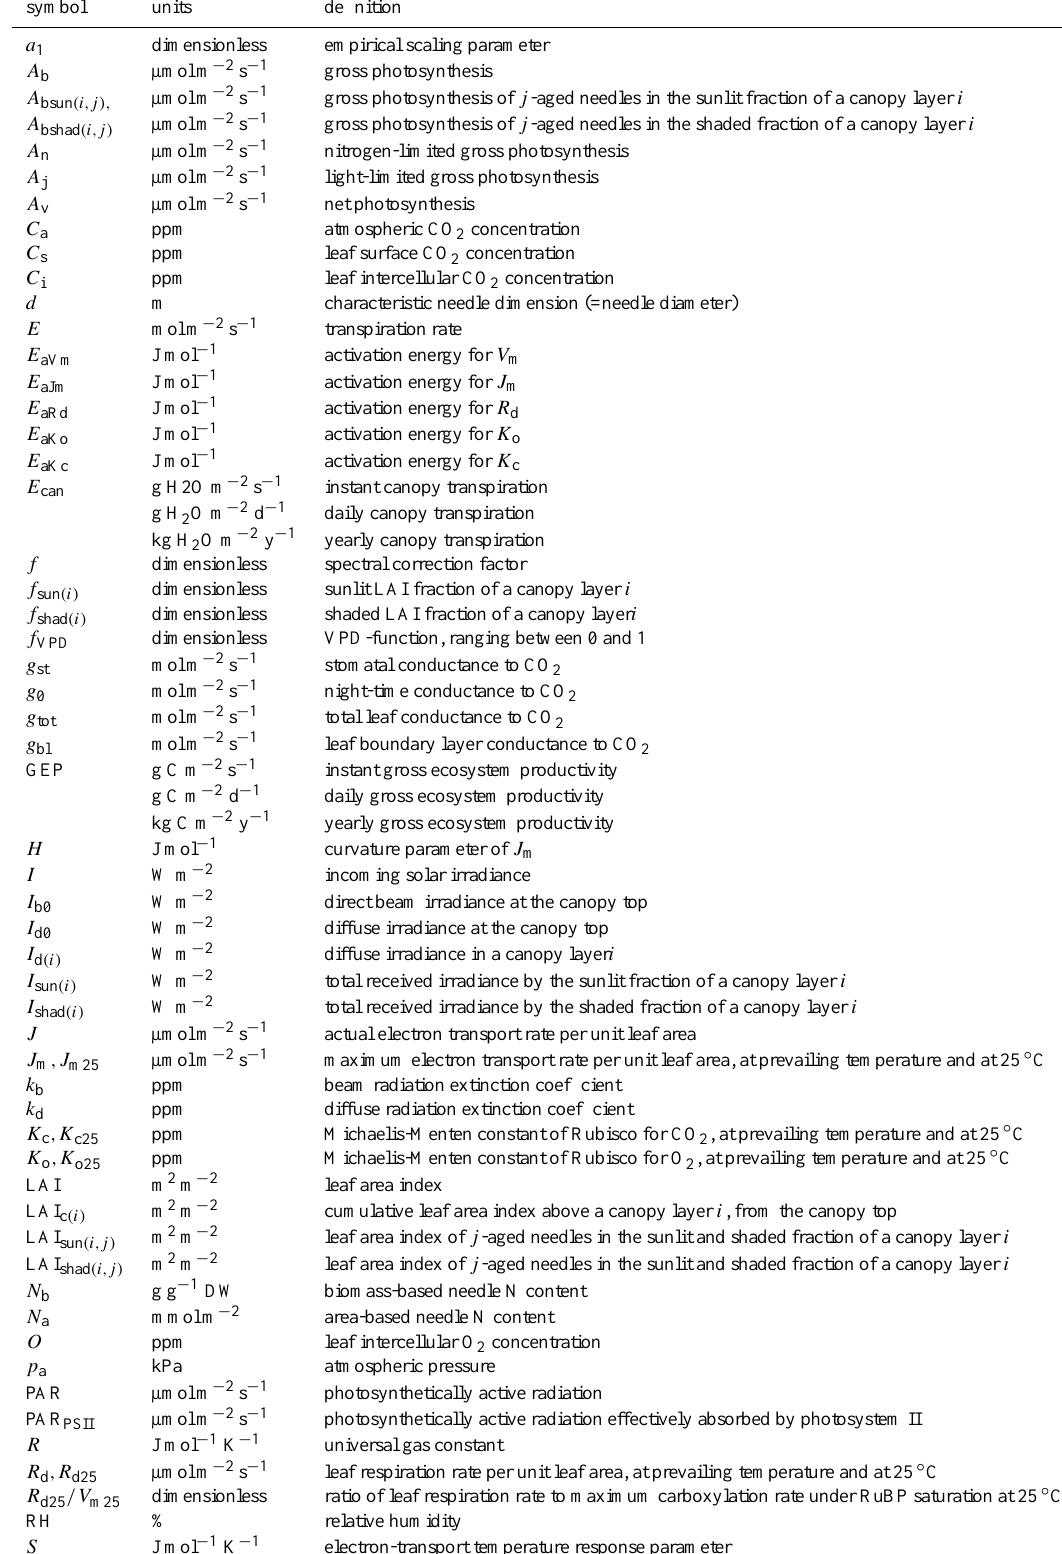
Table 1. List of symbols and notations used in this study, with their units and definition. symbol